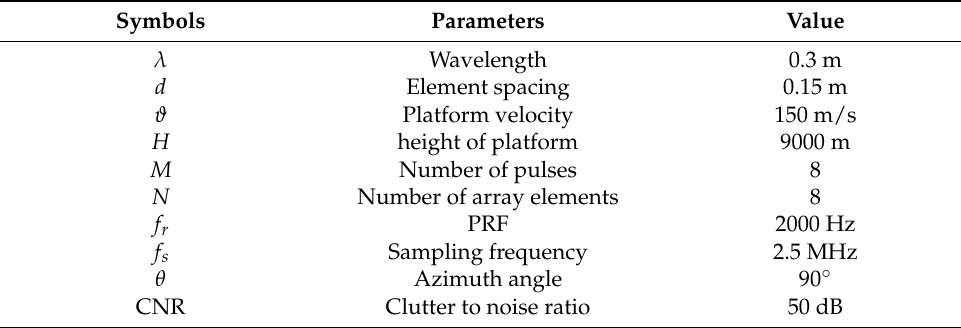
Table 2. List of simulation